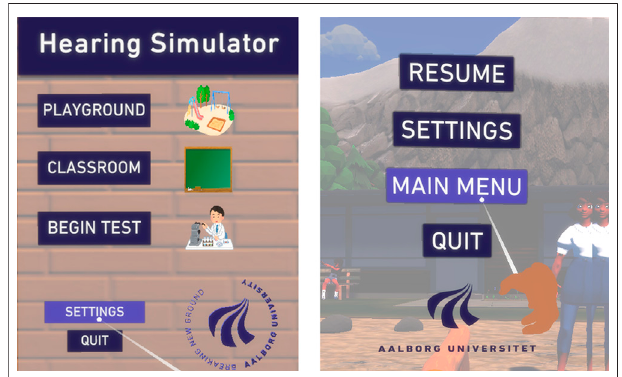
FIGURE 6 | The main menu (A) , and the pause menu accessed by clicking the menu button (B)